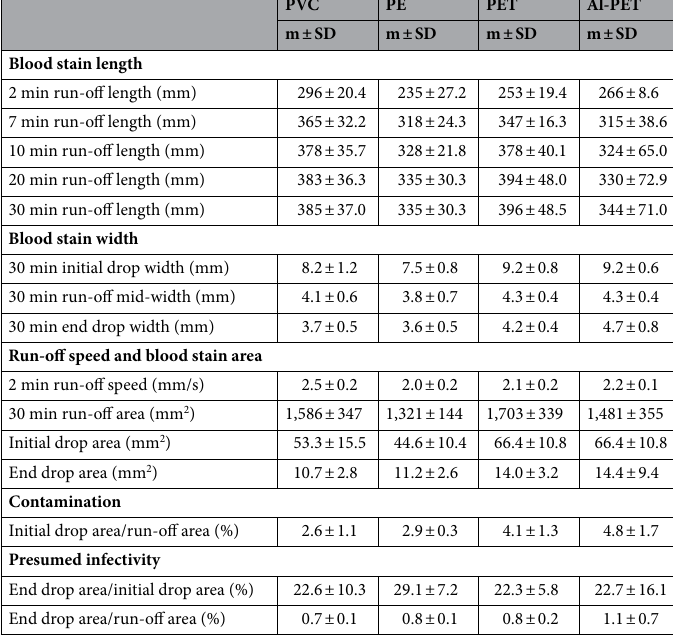
Table 1. Mean run-off diameter after intervals of 2, 7, 10, 20 and 30 min, mean drop area, mean run-off area and mean run-off speed for 100 µl drops in vertically arranged stripes of polyvinyl chloride (PVC), polyethylene (PE), polyethylene terephthalate (PET) and aluminum-coated polyethylene terephthalate